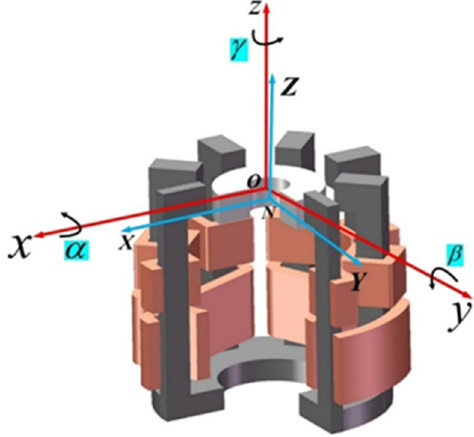
Figure 3. Definition of the coordinate system in